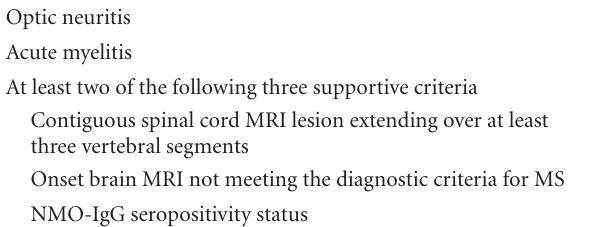
Table 2: Revised criteria for the diagnosis of NMO